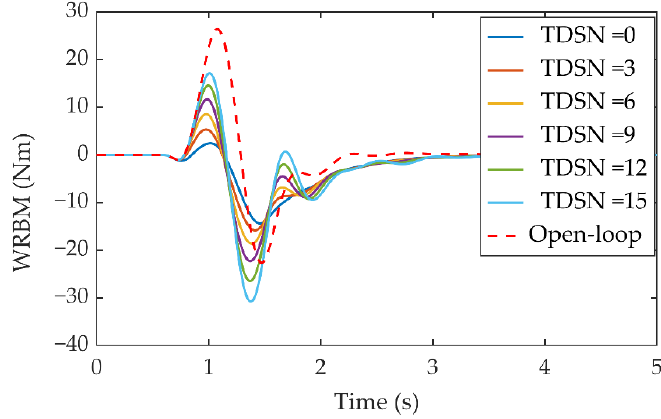
Figure 16. WRBM corresponding to different TDSNs of gust sensor. Table 2. Influence of sensor delay on gust alleviation rate. Table 2. Influence of sensor delay on gust alleviation